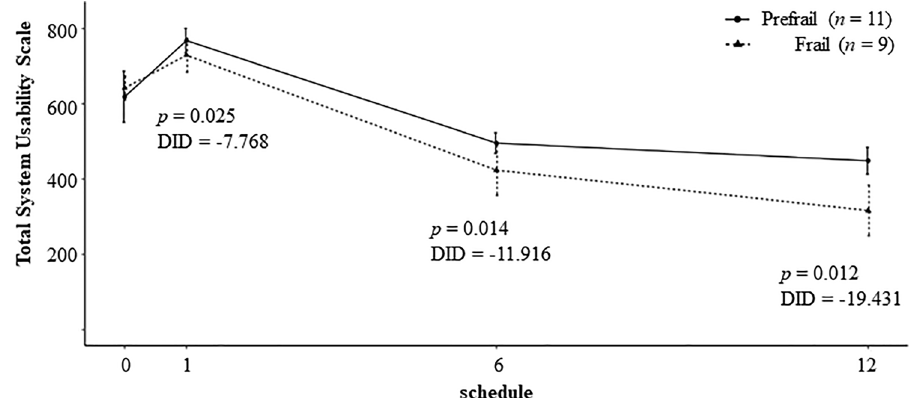
Figure 2. Total system usability scale by frailty status. The usability of the whole services gradually decreased throughout the study period; however it was relatively higher in prefrail group compared with frail group. DID, difference-in-difference. Data preprocessing was conducted by using Python software, version 3.6.8 (The Python Software Foundation, DE, USA), URL https:// www. python. org, and the figure was created by using R